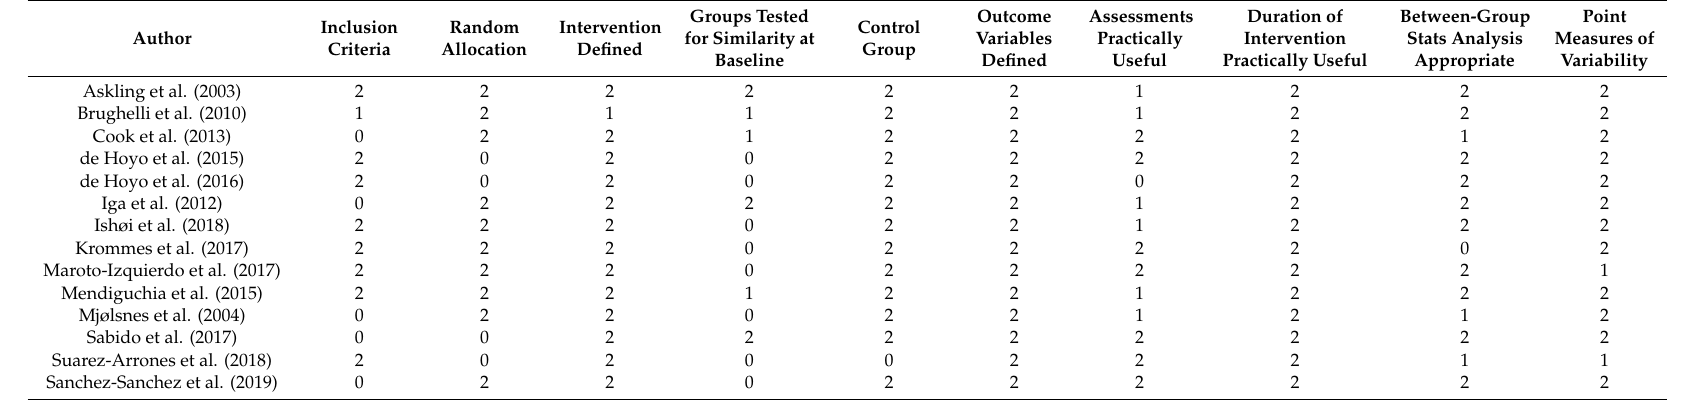
Table 1. Quality assessment for each study included in the